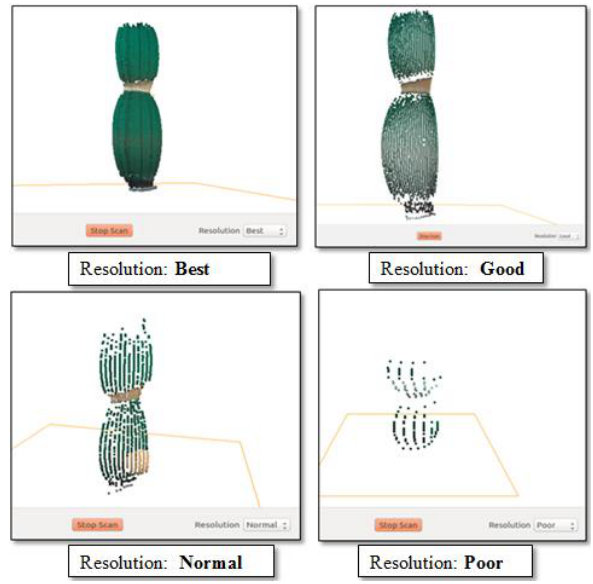
Figure 5. Visual comparison analysis of the cloud of points